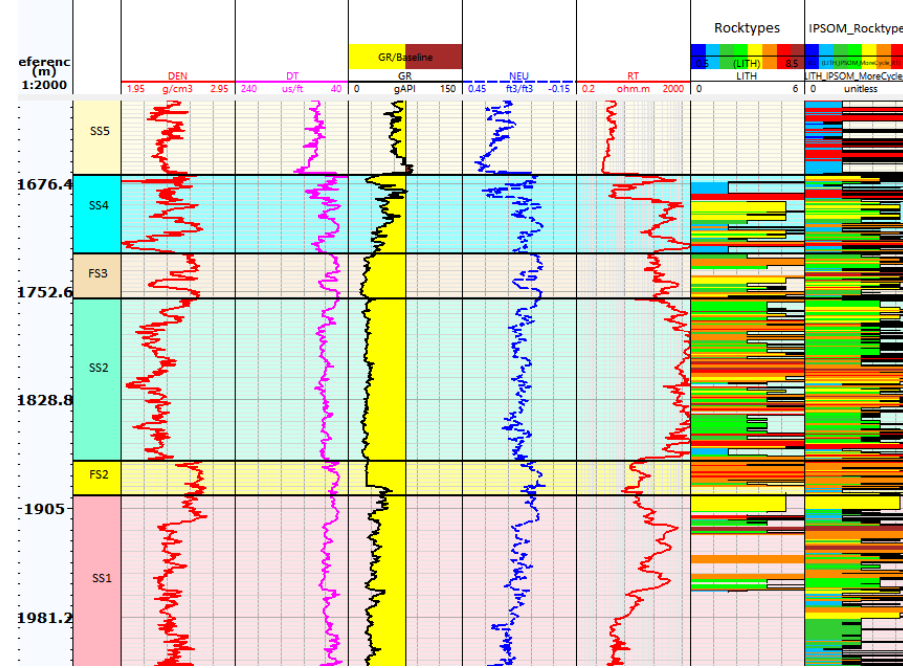
Figure 10. The above graphic shows in Column 8 the predicted rock types of E11-3.